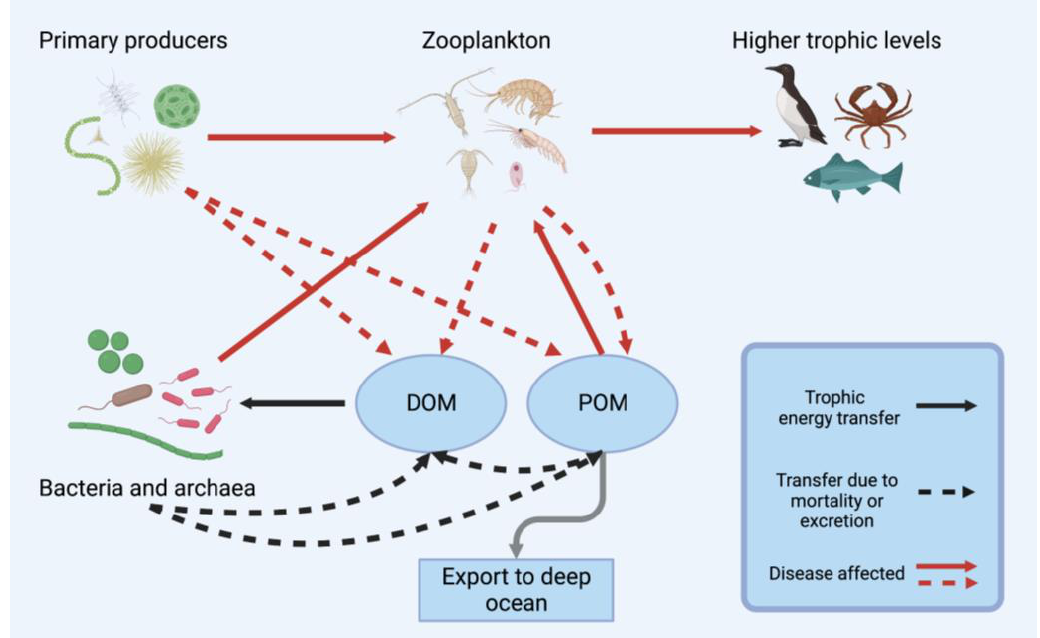
Figure 1. The effects of viral disease and transmission in crustacean zooplankton on pelagic food webs. Solid arrows represent trophic transfer, while dashed arrows represent the regeneration of organic material through mortality or excretion, e.g., cell lysis for primary producers or bacteria and carcasses or faecal pellets for zooplankton. Arrows coloured red represent relationships directly affected as a result of disease. Virus-caused mortality in crustacean zooplankton would result in reduced grazing pressure on primary producers and lower food availability to zooplankton predators. Reduced grazing would lower DOM generation from sloppy feeding but increase export of phytoplankton cells as POM. Mortality would increase POM flux from sinking carcasses but decrease the generation of faecal pellets which liberate DOM and contribute to POM generation.